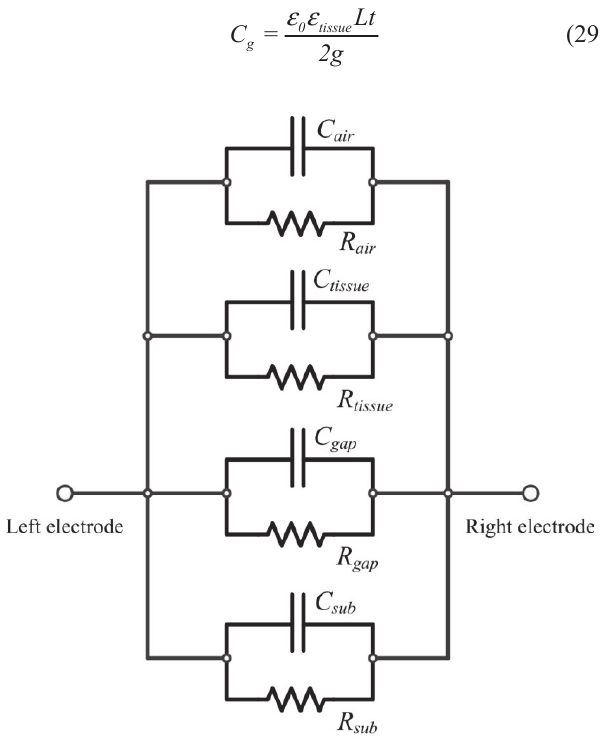
Fig. 6: Equivalent circuit of the multiple layers surrounding the